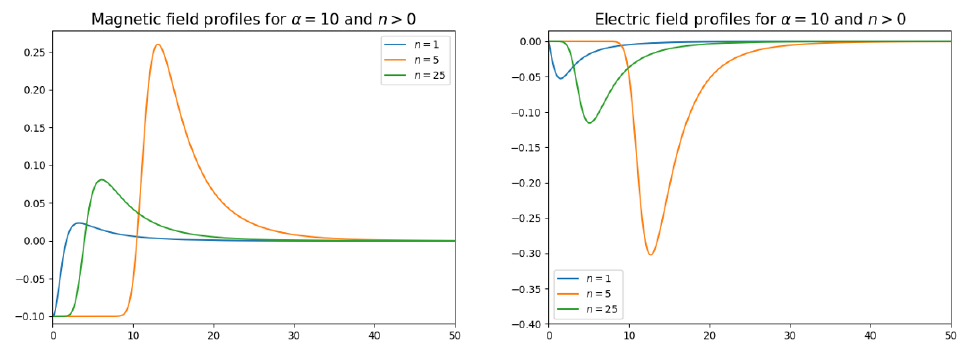
Figure 8 . Magnetic and electric (cid:12)elds for positive (cid:13)ux vortices have support near the edge of the vortex and their peak values grow without bound as n is